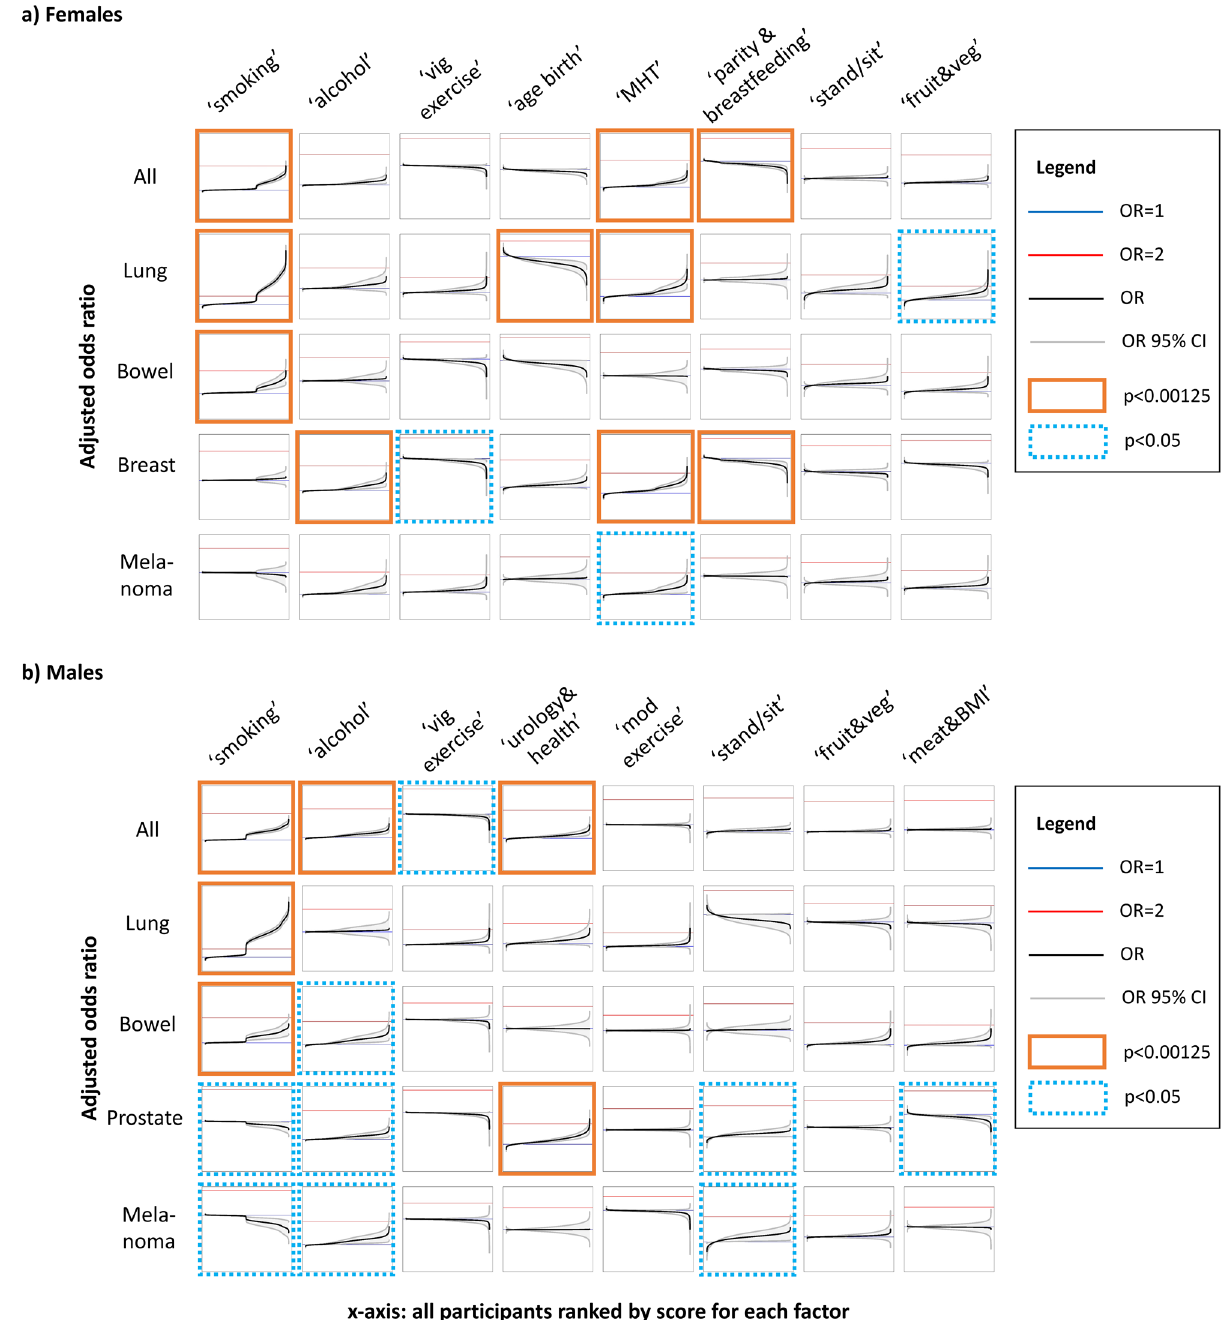
Figure 4. Association between combined factor scores and cancer incidence for ( a ) females and ( b ) males. Adjusted odds ratio (OR; y-axis) for study participants depending on factor score (x-axis), with all other covariates held constant, and the individual with 12.5% percentile score as reference (OR = 1). Odds ratios are adjusted for age, BMI, self-reported health at baseline, the number of GP visits in the 2 years prior to baseline, private health insurance, remoteness of residence, and where relevant, self-reported participation in cancer screening prior to baseline, or tannability-related covariates (see “Methods”). All estimates and results from sensitivity analyses see Supplementary Table S6. vig vigorous, age birth age at childbirth, MHT menopausal hormone therapy, stand/sit standing/sitting, veg vegetables, mod moderate, BMI Body Mass